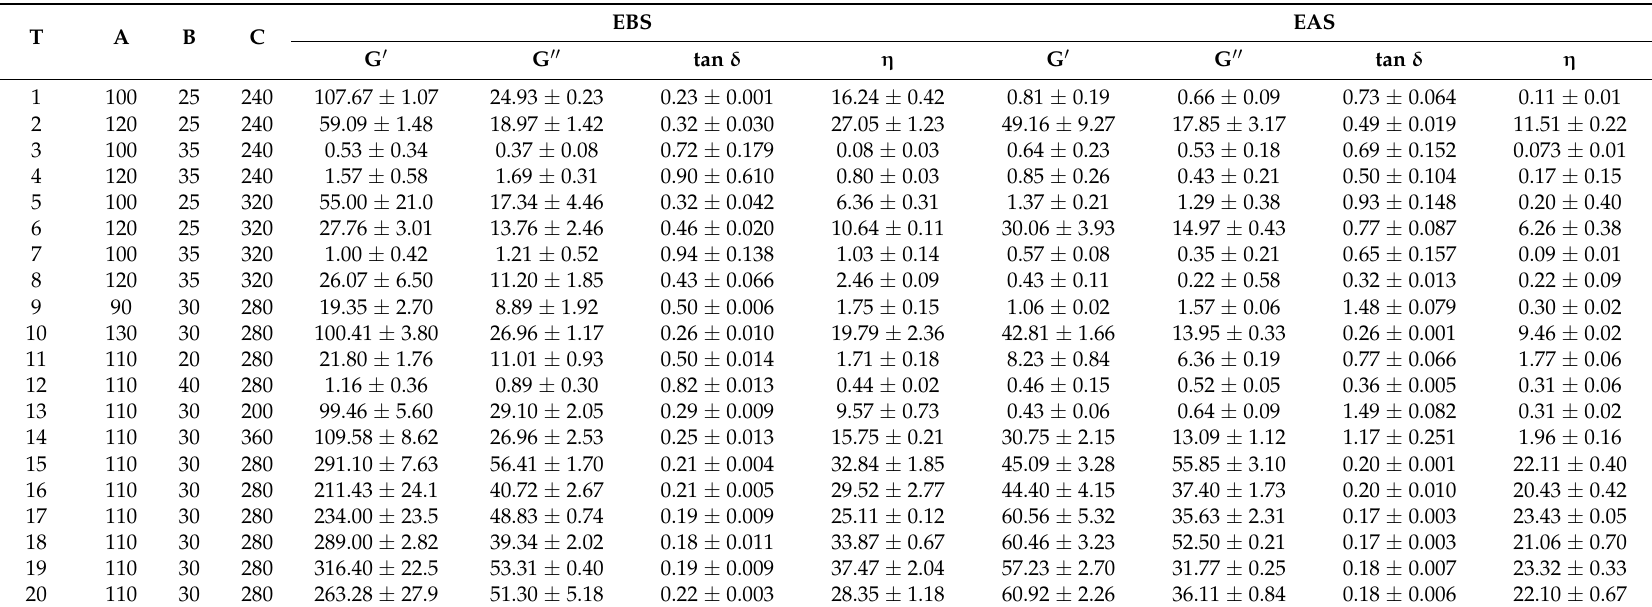
Table 3. Rheological properties of extruded cornstarch at different process